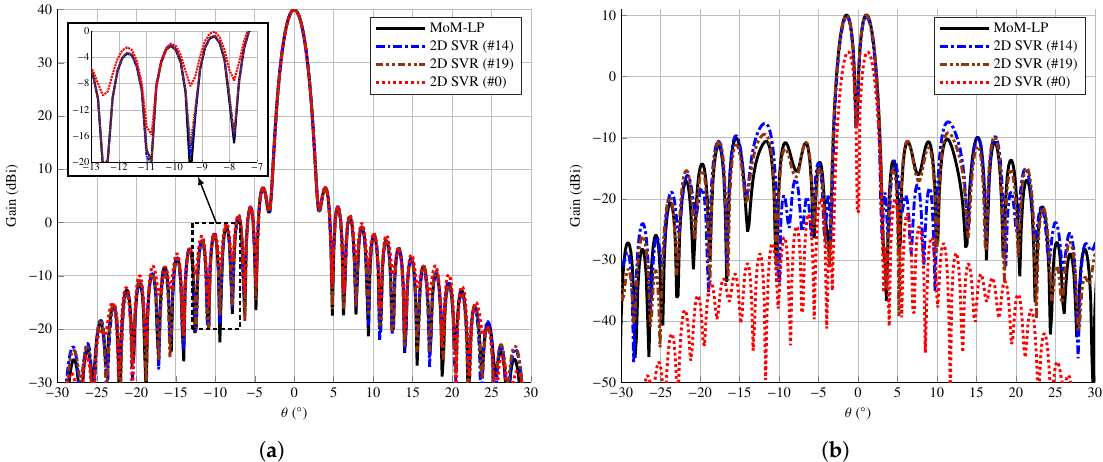
Figure 7. Main cut of a pencil beam ( ϕ = 90°) for the ( a ) copolar and ( b ) crosspolar radiation pattern for polarization V comparing the MoM-LP and SVR predictions.